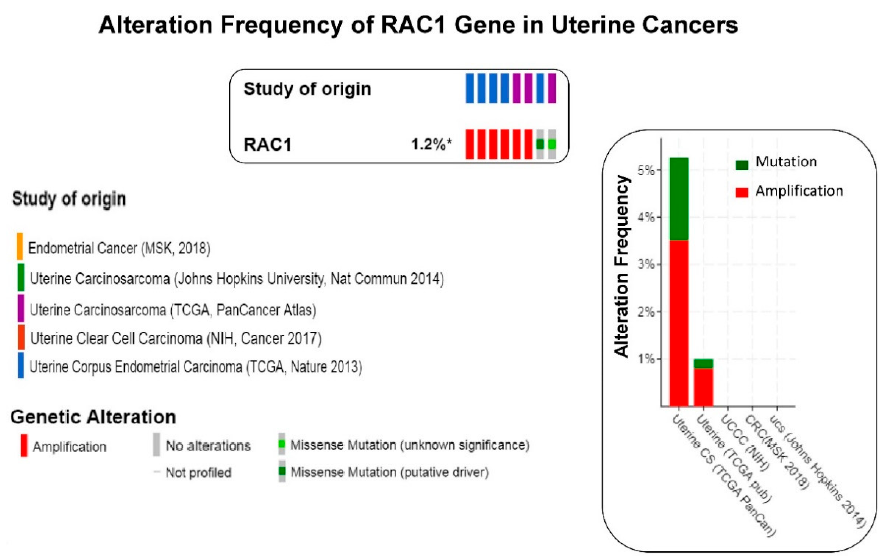
Figure 4. The frequency of alteration of RAC1 gene in uterine cancers: The oncoprint presents data obtained from c-BioPortal (February 2019) representing a combined study of 792 samples (http: // www.cbioportal.org), querying 784 patients / 792 samples in five studies as shown in di ff erent color codes of the oncoprint (upper panel) under “Study of origin” in the figure. The percentage